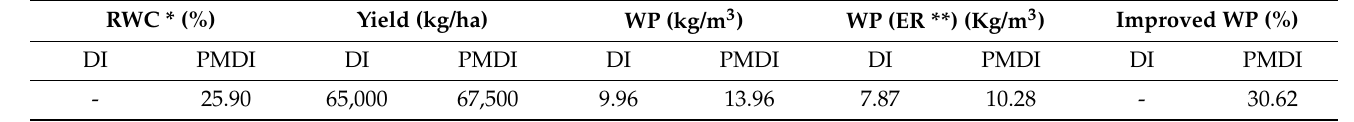
Table 7. Yield and WP in research treatments.